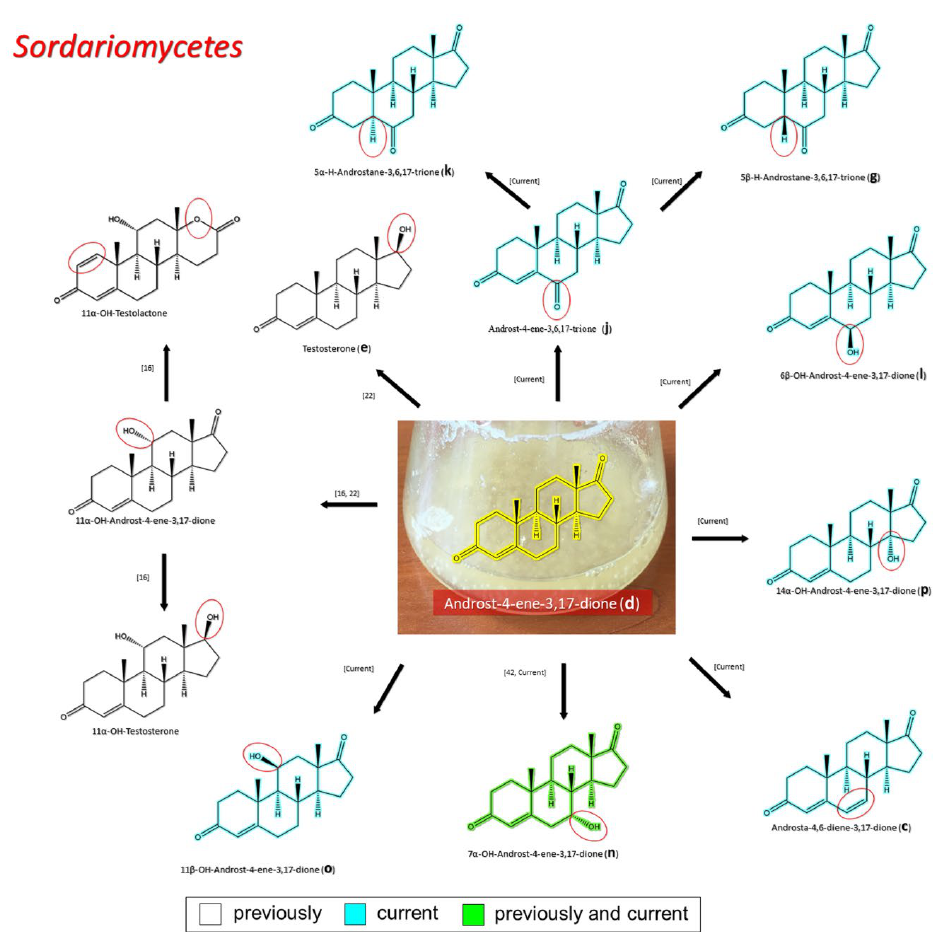
Figure 6. The transformation of androst-4-ene-3,17-dione ( d ) by Sordariomycetes . Structural formula of the substrate ( d ) is drawn in yellow and placed on the image of the flask with defined (DE) medium after 48 h of transformation for by Simplicillium lamellicola STG-96. Structural formulas of steroids detected during the transformation are drawn: in green for compounds found both in current and in other studies; in black for compounds found in other studies, but not found in current work; and in blue for compounds first discovered in current study. Next to the arrows are the literary sources, where modifications were described; modifications circled in red ovals.